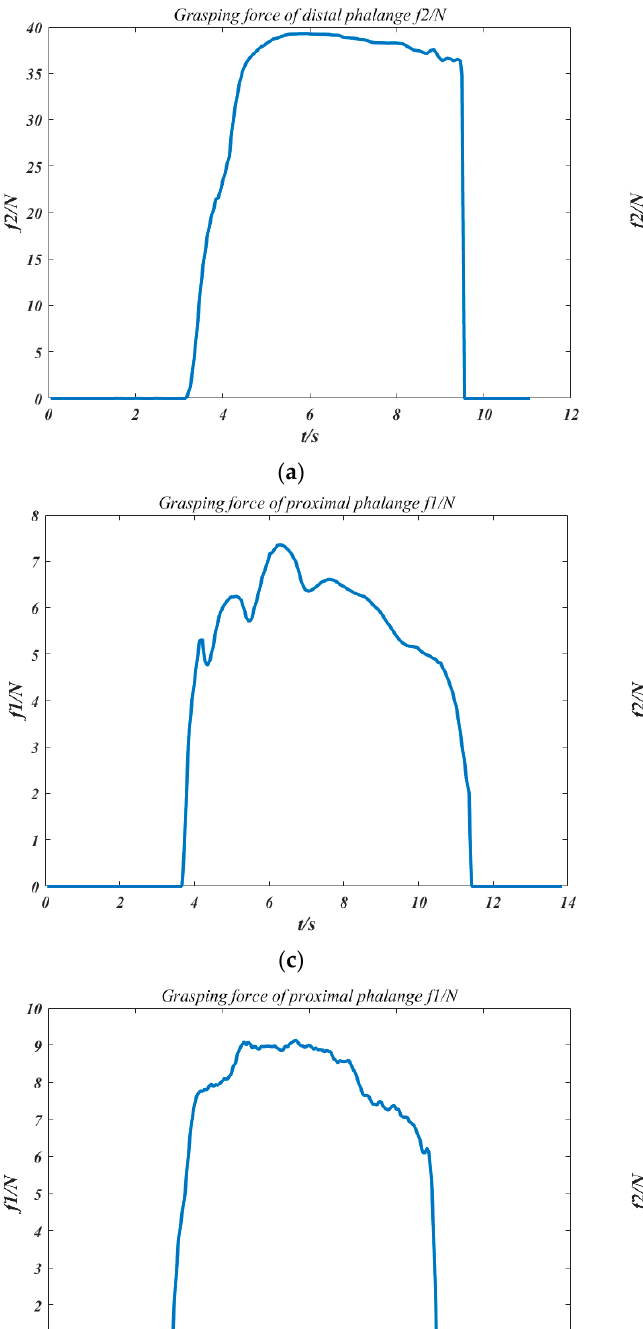
( e ) Grasping force of proximal phalange in experiment scenario 4; ( f ) Grasping force of distal phalange phalange in experiment scenario 4.